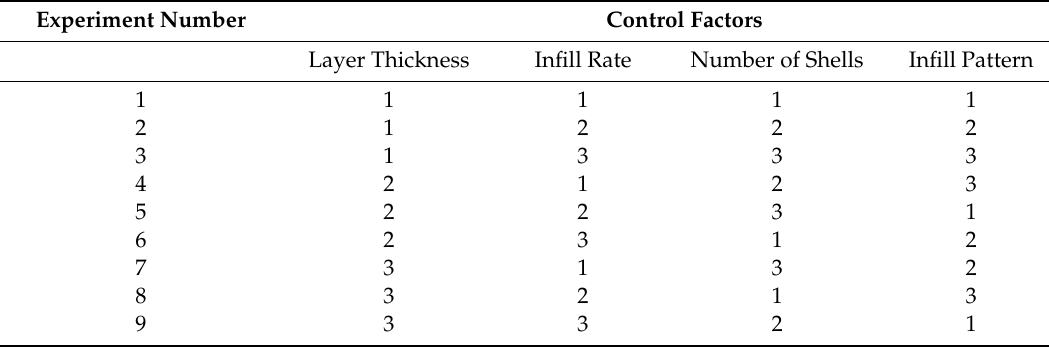
Table 3. Taguchi L9 (3 4 ) orthogonal array generated for the